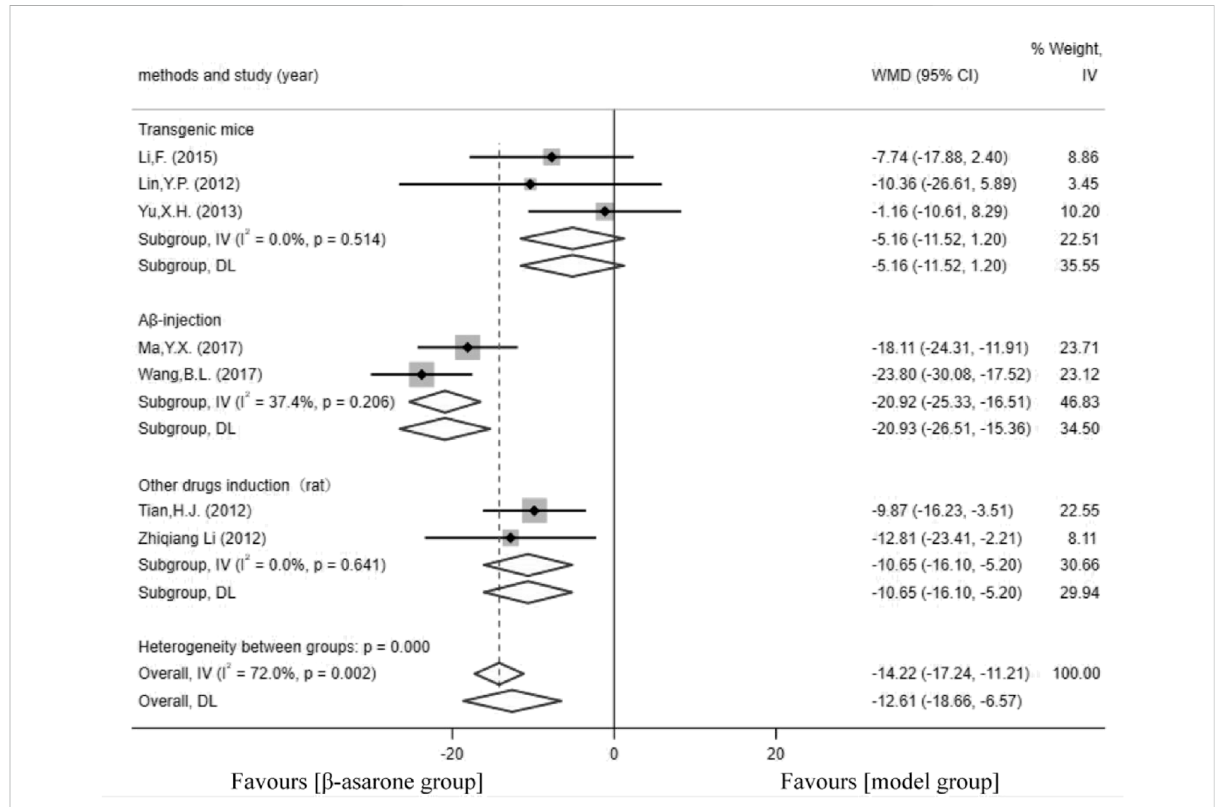
FIGURE 3 Forest plot for comparison: β -asarone group versus model group. Outcome: escape